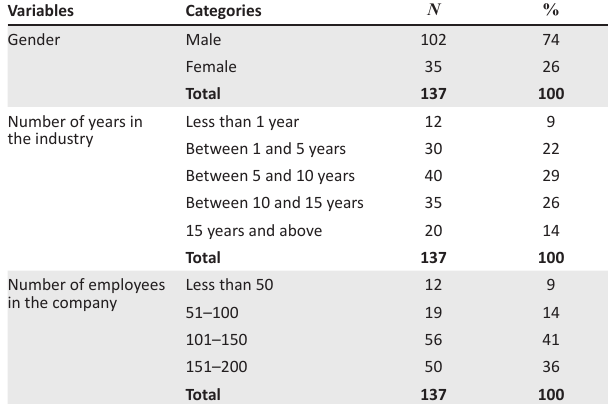
TABLE 2: Combined demographics and small and medium enterprises profile.